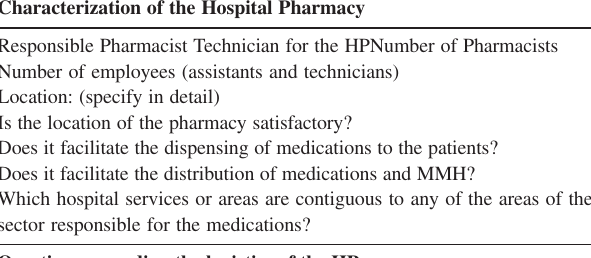
Table 1 - Questions included in the research instrument Characterization of the Hospital Pharmacy